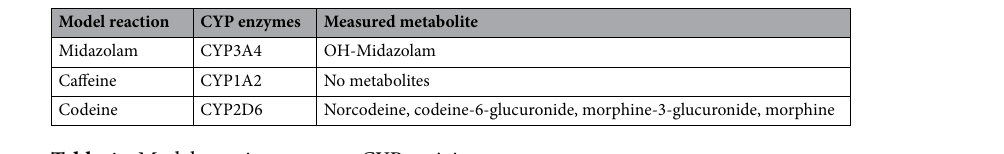
Table 4. Model reaction to assess